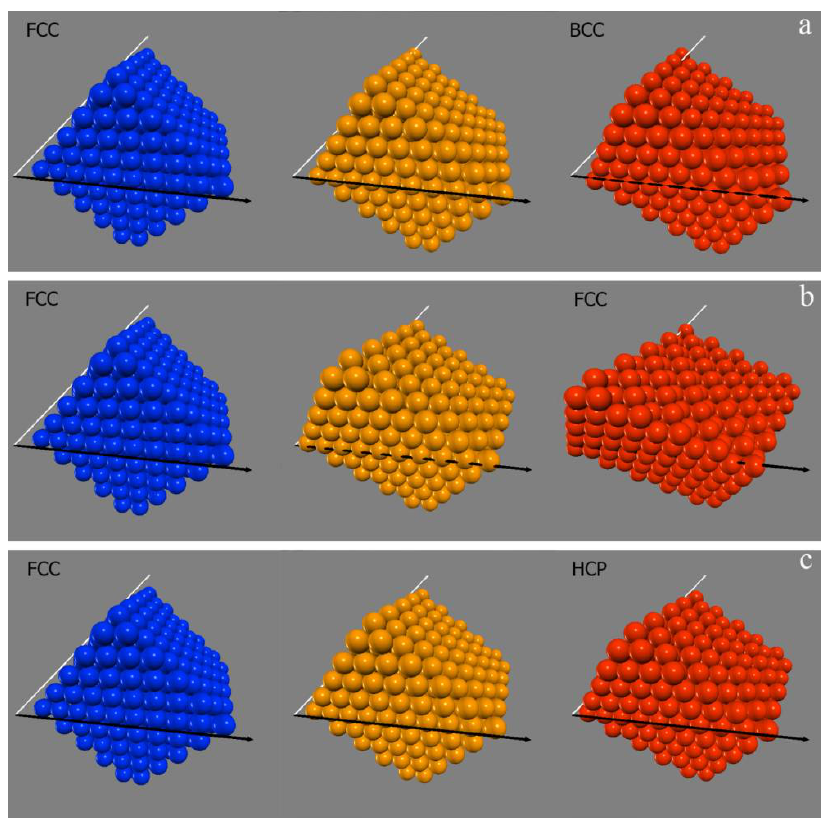
Figure 27. Snapshots of 3D simulation movies of ( a ) an fcc ⟶ bcc martensitic transformation. ( b ) fcc ⟶ fcc mechanical twinning. ( c ) fcc ⟶ hcp martensitic transformation, with, in blue, the initial parent fcc cube with its {100} γ facets; in red, the resulting transformed daughter crystals; and in yellow, the intermediate states stopped at midway (half of the maximum distortion angle). The black arrow represents the invariant line PO , and the white arrow the direction PK (also invariant for the fcc ⟶ hcp and fcc ⟶ fcc transformations). Reprinted from [123] with permission from Elsevier.